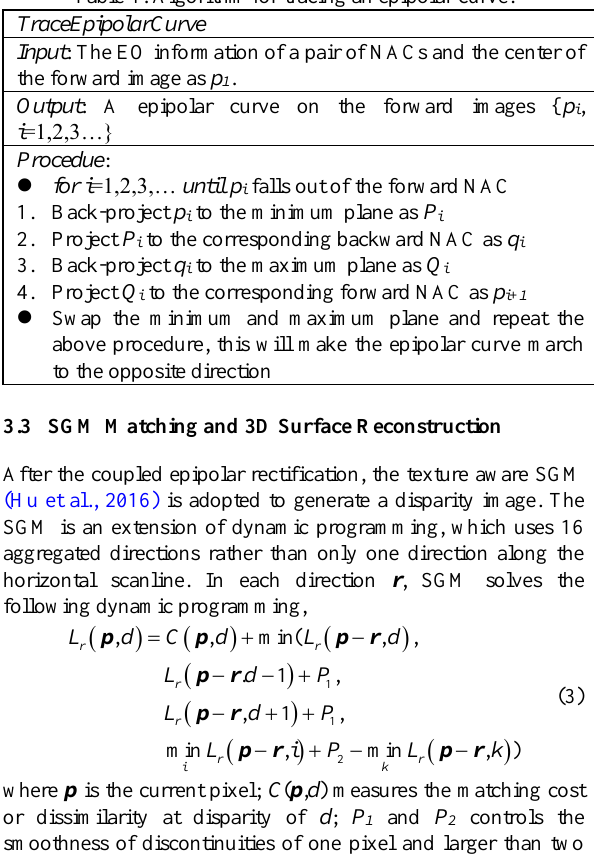
feature matching. After feature matching and tracks